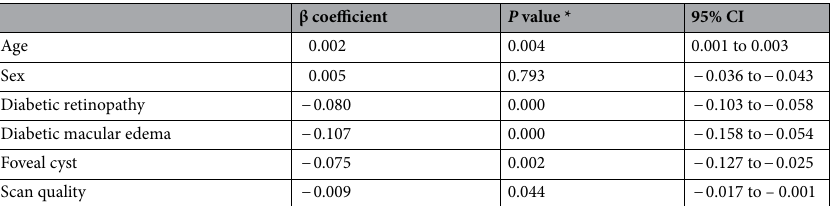
Table 2. Summary of univariate regression model using absolute differences between manual and automated foveal avascular zone area as an outcome variable. * P values were calculated using generalized estimating equations to adjust for inter-eye